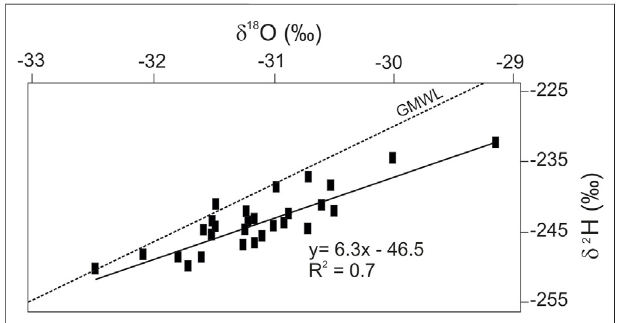
FIGURE 8 | Ratio of δ 18 O and δ 2 H values in the late Pleistocene ice wedges of the Syrdakh outcrop. GMWL, global meteoric water